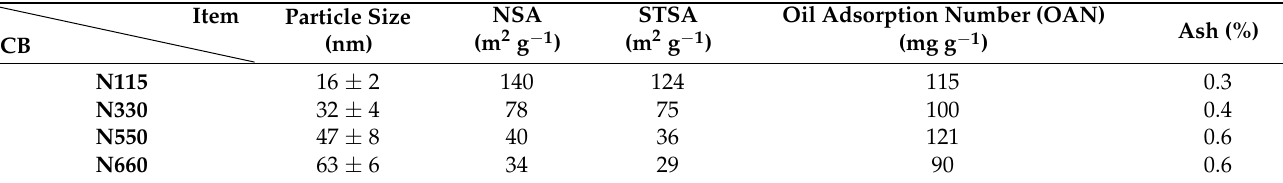
Table 2. Structural properties of CB used in this